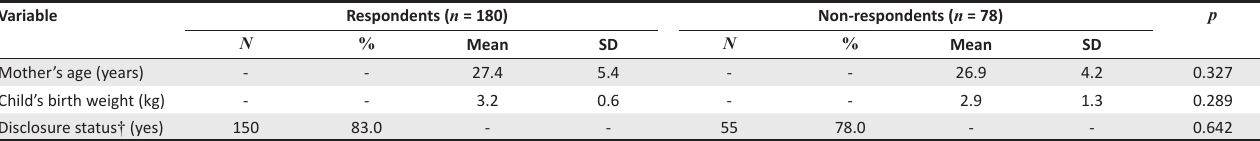
FIGURE 3: Summary of inclusion and exclusion of participants. TABLE 1: Differences in characteristics of respondents versus